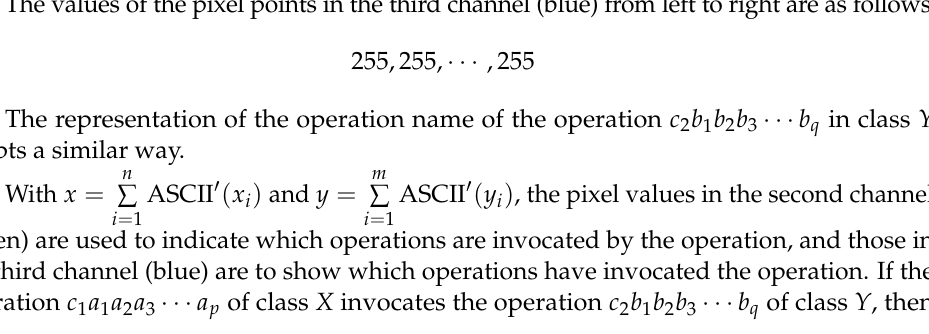
The values of the pixel points in the third channel (blue) from left to right are as follows: The values of the pixel points in the second channel (green) from left to right are as